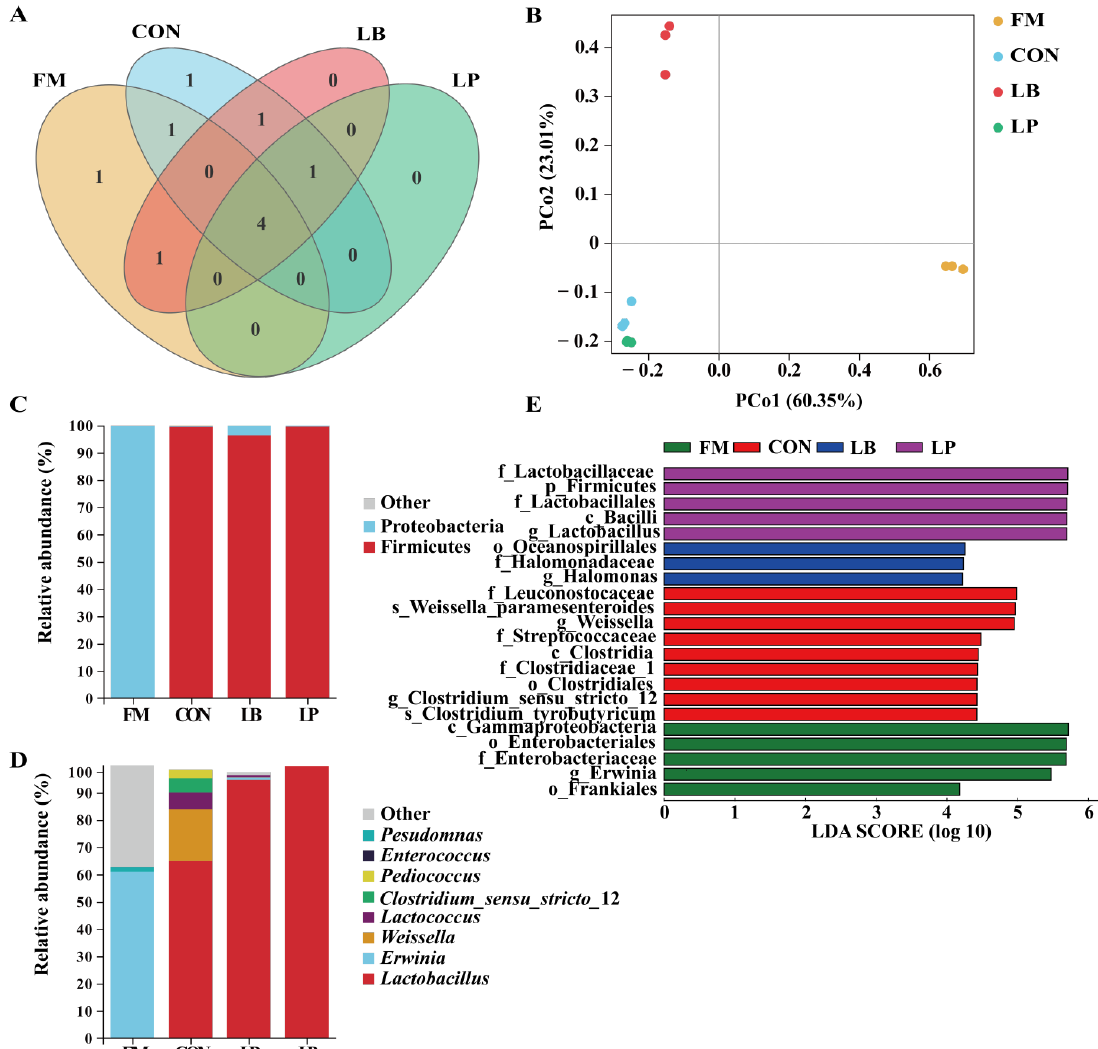
Figure 1. Bacterial diversity and community structure in fresh materials and silages ( n = 3). ( A ) Venn diagram representing the common and unique ASVs found in fresh materials and silages. ( B ) Prin- cipal component analyses (PCoA) of samples conducted based on Bray UniFrac distance. ( C ) The relative abundance (%) of bacterial phyla (1% at least in one group) of FM and forage oat silage at the phylum level. ( D ) The relative abundance (%) of bacterial phyla (1% at least in one group) of FM and forage oat silage at the genus level. ( E ) Linear discriminant analysis (LDA) effect size (LEFSe) histogram showing the LDA scores (>4.0) computed for features at the OTU level. The length of the histogram represents the LDA score of different species. FM, fresh material; CON, control group; LB, Lactiplantibacillus buchneri inoculated treatment; LP, Lentilactobacillus plantarum inoculated